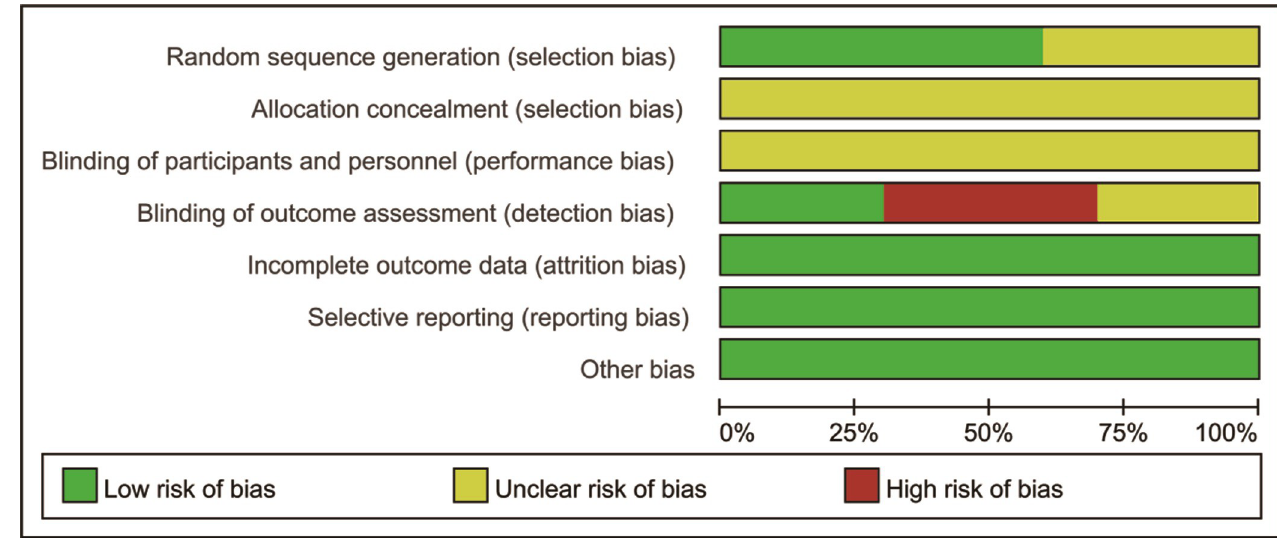
Fig 2. Risk of bias